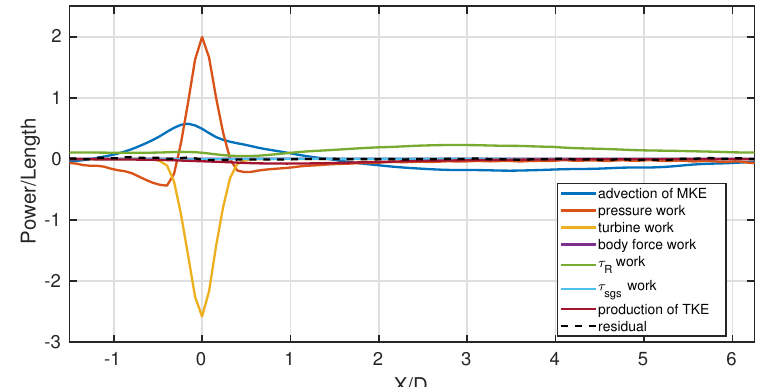
Figure 5. Mean kinetic energy equation terms integrated over the streamtube cross-section for = 1.33. Each term is normalized by the total turbine power, such that the integral of the turbine C (cid:48) T power curve is − 1. X / D = 0 is the location of the actuator disk, and the x-axis extends the length of the separation between turbine rows. The residual is the sum of all other